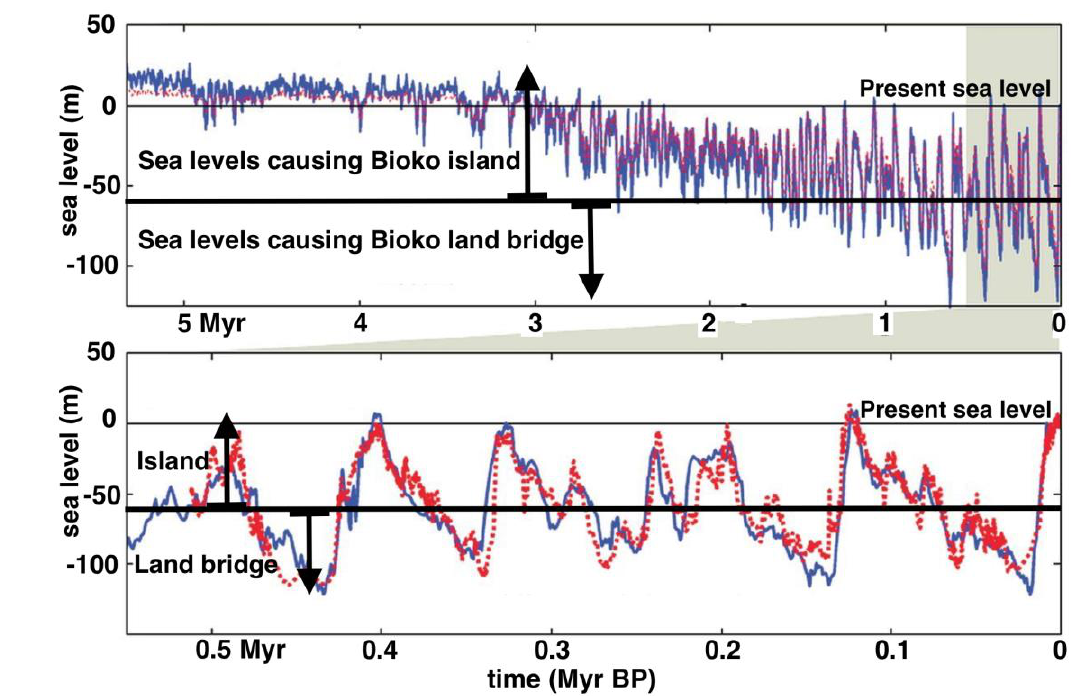
Figure 4. Estimates of sea levels over the past 5.3 and past 0.55 million years. Diagrams modified from Hansen et al.